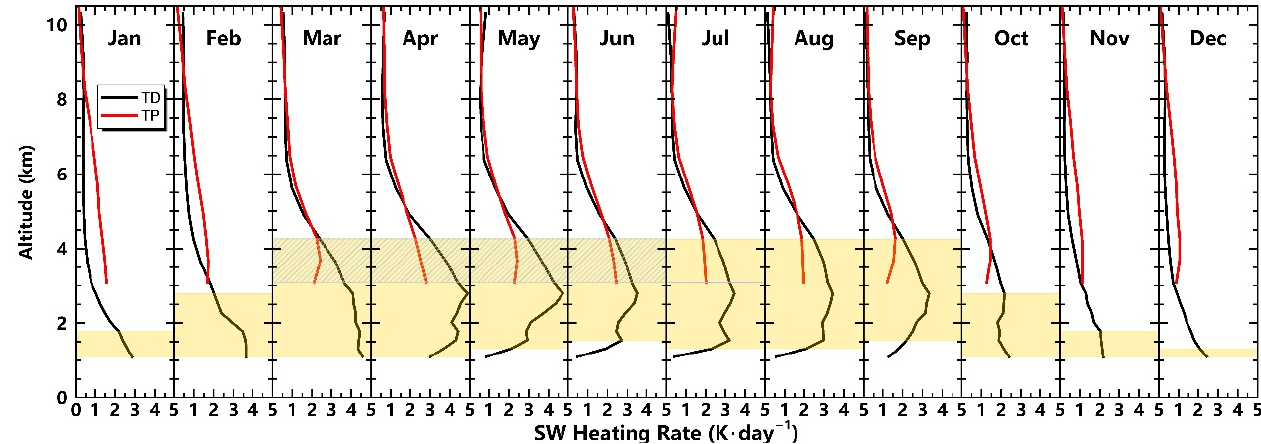
Figure 10. Monthly SW DHR profiles over TD and TP. The shaded areas filled with the yellow color and the slanted lines are the heating layers with DHR > 2 K · day − 1 over TD and TP, respectively.